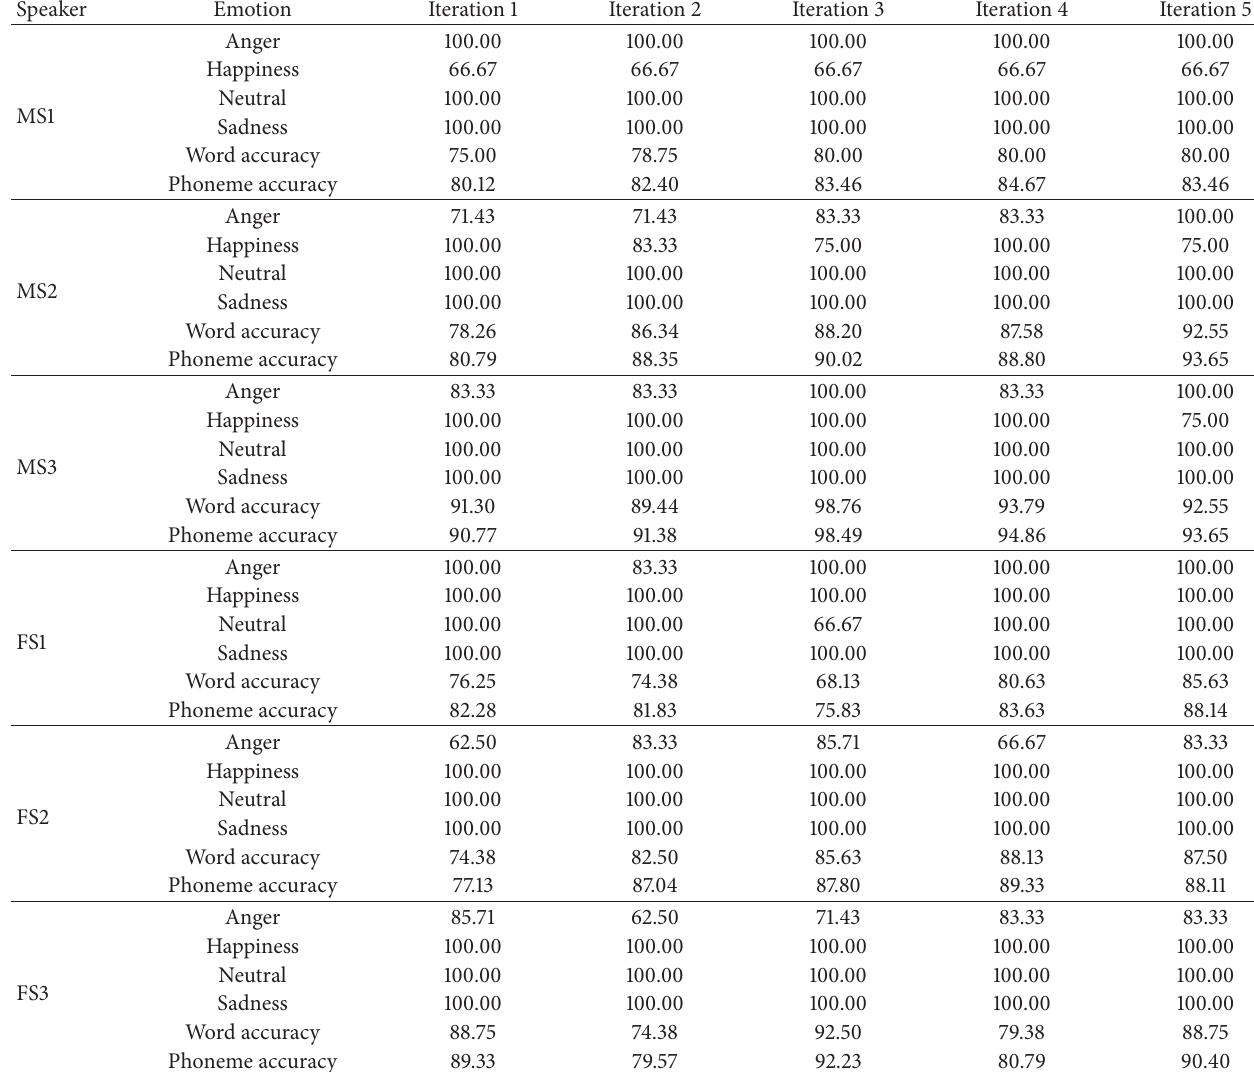
Table 8: Classification performance of the ASR system for speech and emotion recognition (individual speakers from the speech corpus) across five